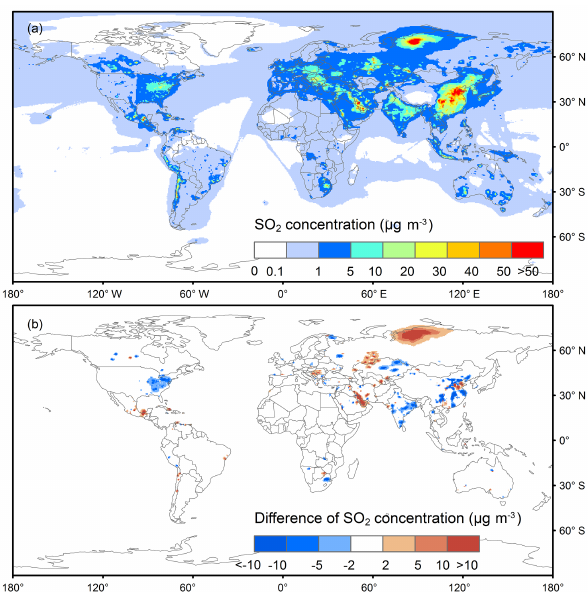
Figure 3. Annual mean surface SO 2 concentration in 2010 based on the GEOS-5 model driven by the OMI-HTAP inventory, 2010 (a) , and the differences between the modeled SO 2 using the OMI-HTAP and the HTAP inventory, 2010 (b) . SO 2 concentrations using the HTAP inventory are subtracted from those in the OMI-HTAP in- ventory to derive the